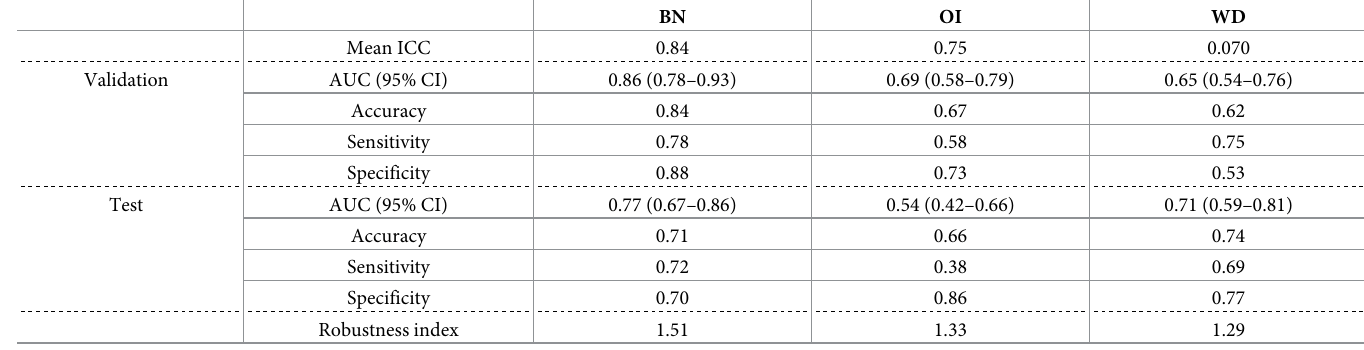
Table 4. Summary of mean intra-class correlation coefficients (ICCs), areas under the receiver operating characteristic curves (AUCs) with 95% confidence inter- vals (CIs), accuracies, sensitivities, specificities and robustness indices from Betti number (BN)-, original image (OI)-, and wavelet decomposition (WD)-based models to the identification of epidermal growth factor receptor